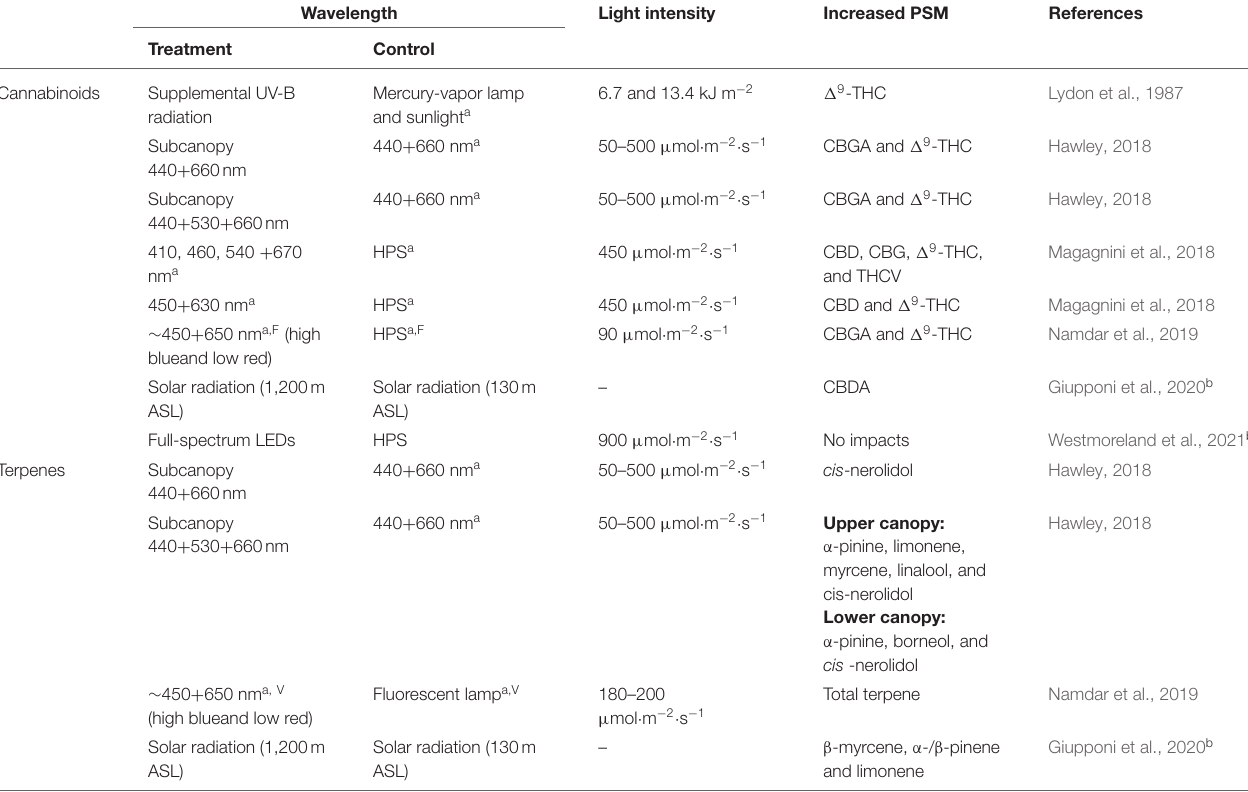
TABLE 1 | A comparison of cannabis PSM yield data compiled with overhead, subcanopy, or supplemental